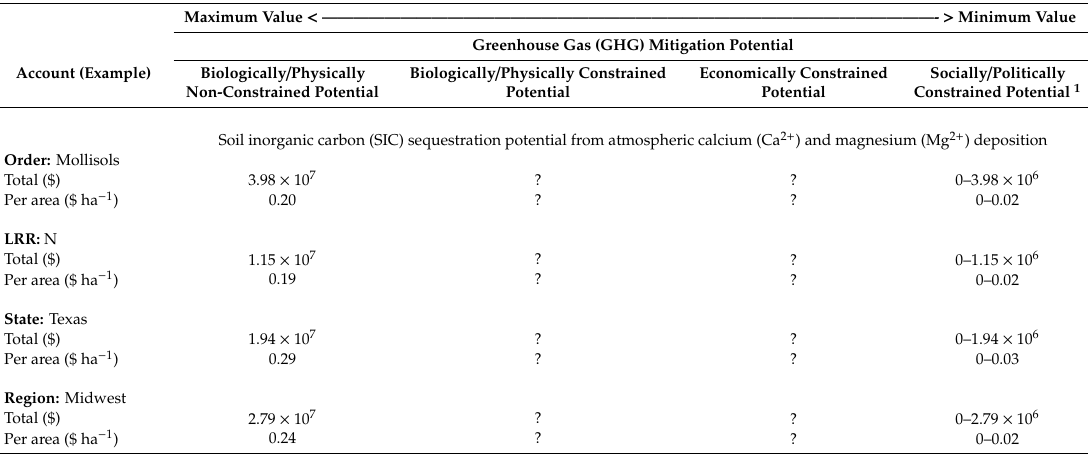
Table 7. Impact of di ff erent constraints on reducing the greenhouse gas (GHG) mitigation potential (its value) (modified from Smith et al. 2005 [21]), and examples from this